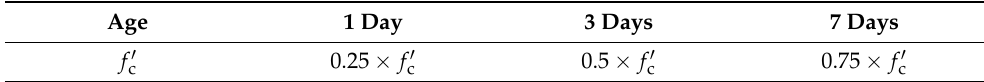
Table 3. Evolution of concrete